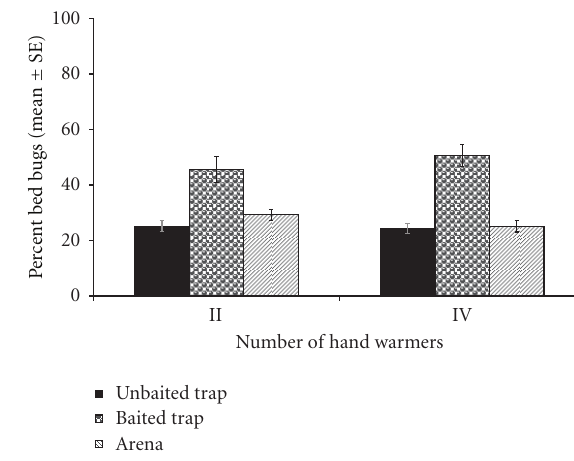
Figure 2: E ff ect of CO 2 release rate on bed bug trap e ffi cacy. Figure 3: E ff ect of heat on bed bug trap e ffi cacy.